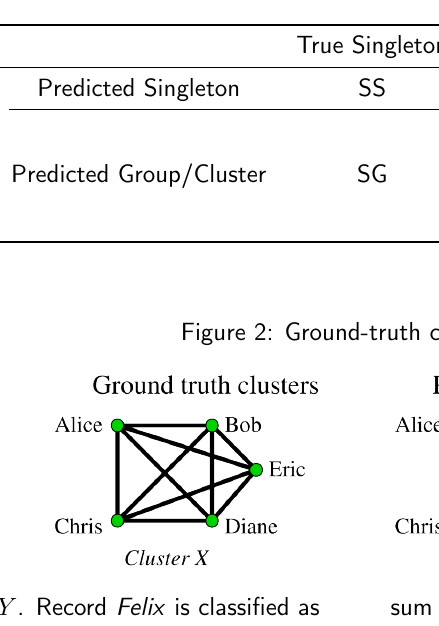
Table 4: Confusion matrix for the seven categories described in Table 3